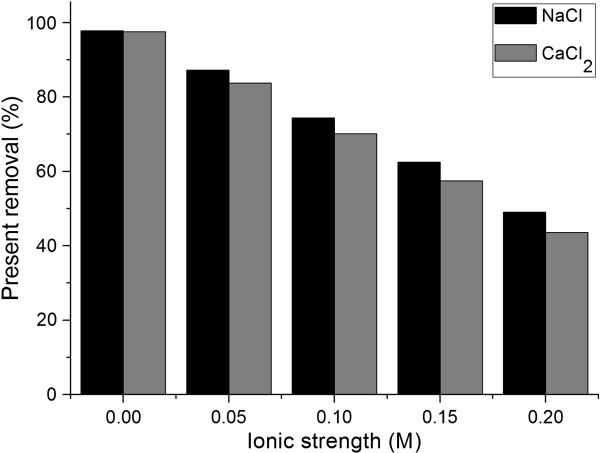
Effect of Na
+
 and Ca
2+
 on percent removal.